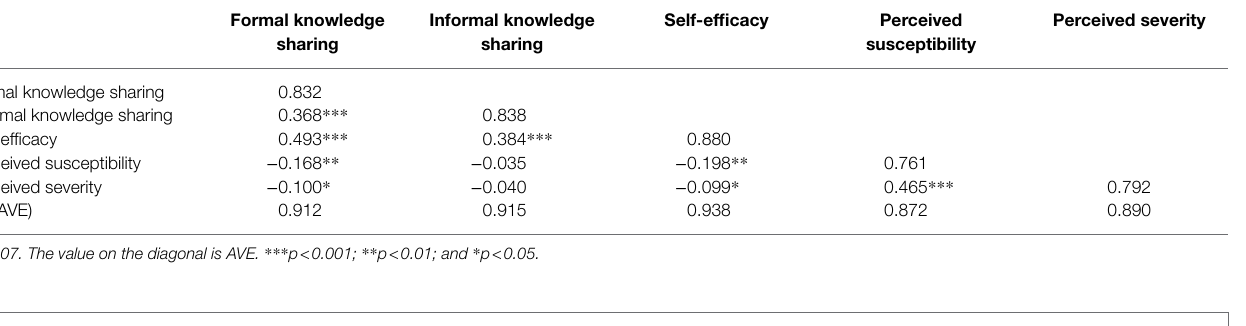
TABLE 3 | Discriminant validity results.